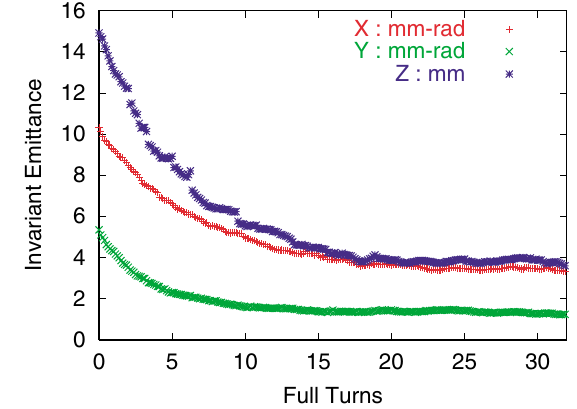
FIG. 43. (Color) The evolution of x , y , z normalized emittances in 32 full turns.